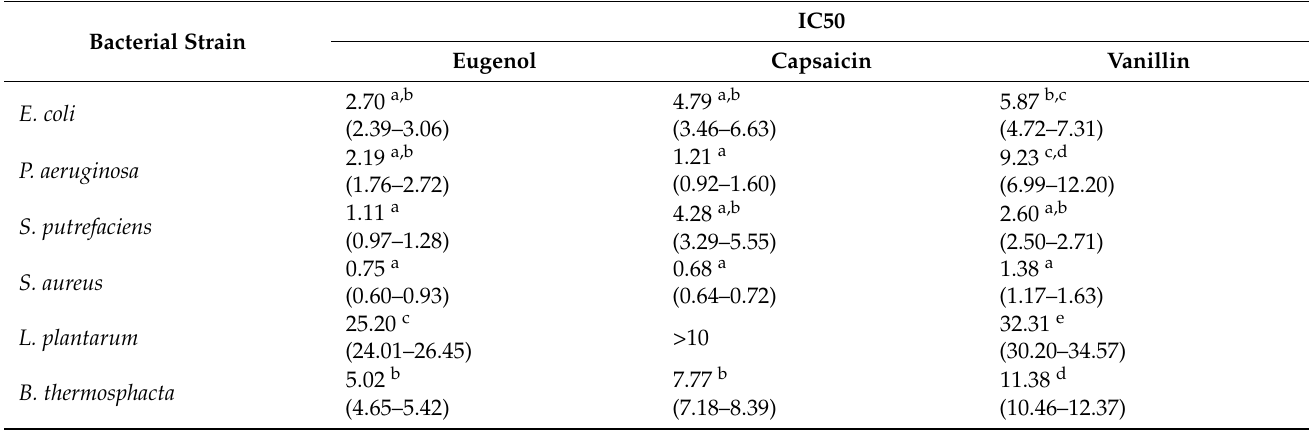
Table 2. Median concentrations of bacterial growth inhibition (IC50s). IC50 values, coming from the interpolation of three independent experiments, are expressed in mM with a 95% confidence range (in brackets). Letters indicate the significant differences among different strains for each phytochemical, one-way ANOVA, Tukey’s multiple comparison test ( p < 0.05). Bacterial Strain